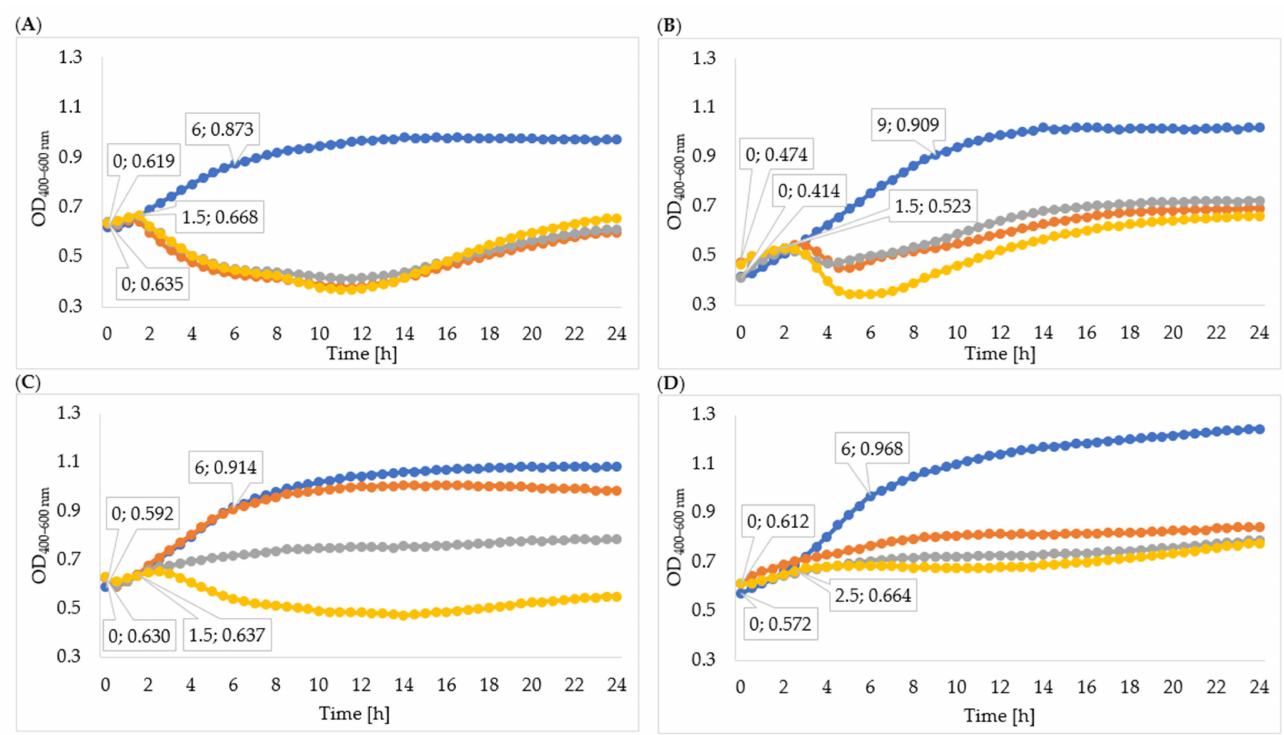
Figure 4. Growth curves of tested bacteria cultured with enzymes isolated with acetone: ( A )— Enterobacter cloacae KKP 3082; ( B )— Serratia liquefaciens KKP 3654; ( C )— Enterobacter cloacae KKP 3684; ( D )— Serratia marcescens KKP 3687. The beginning and the end of logarithmic growth phases for control and tested bacteria strains cultured with enzymes isolated after 72-hour propagation are marked in the figure ( n = 10). Blue line—control culture, orange line—culture infected with phages propagated for 24 h, grey line—culture infected with phages propagated for 48 h, yellow line—culture infected with phages propagated for 72